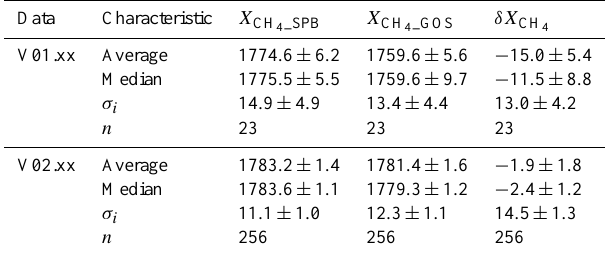
Table 1. Average characteristics (in ppb) for the data shown in Fig. 2. Shown uncertainties correspond to 0.95 confidence intervals. VMR units are parts per billion